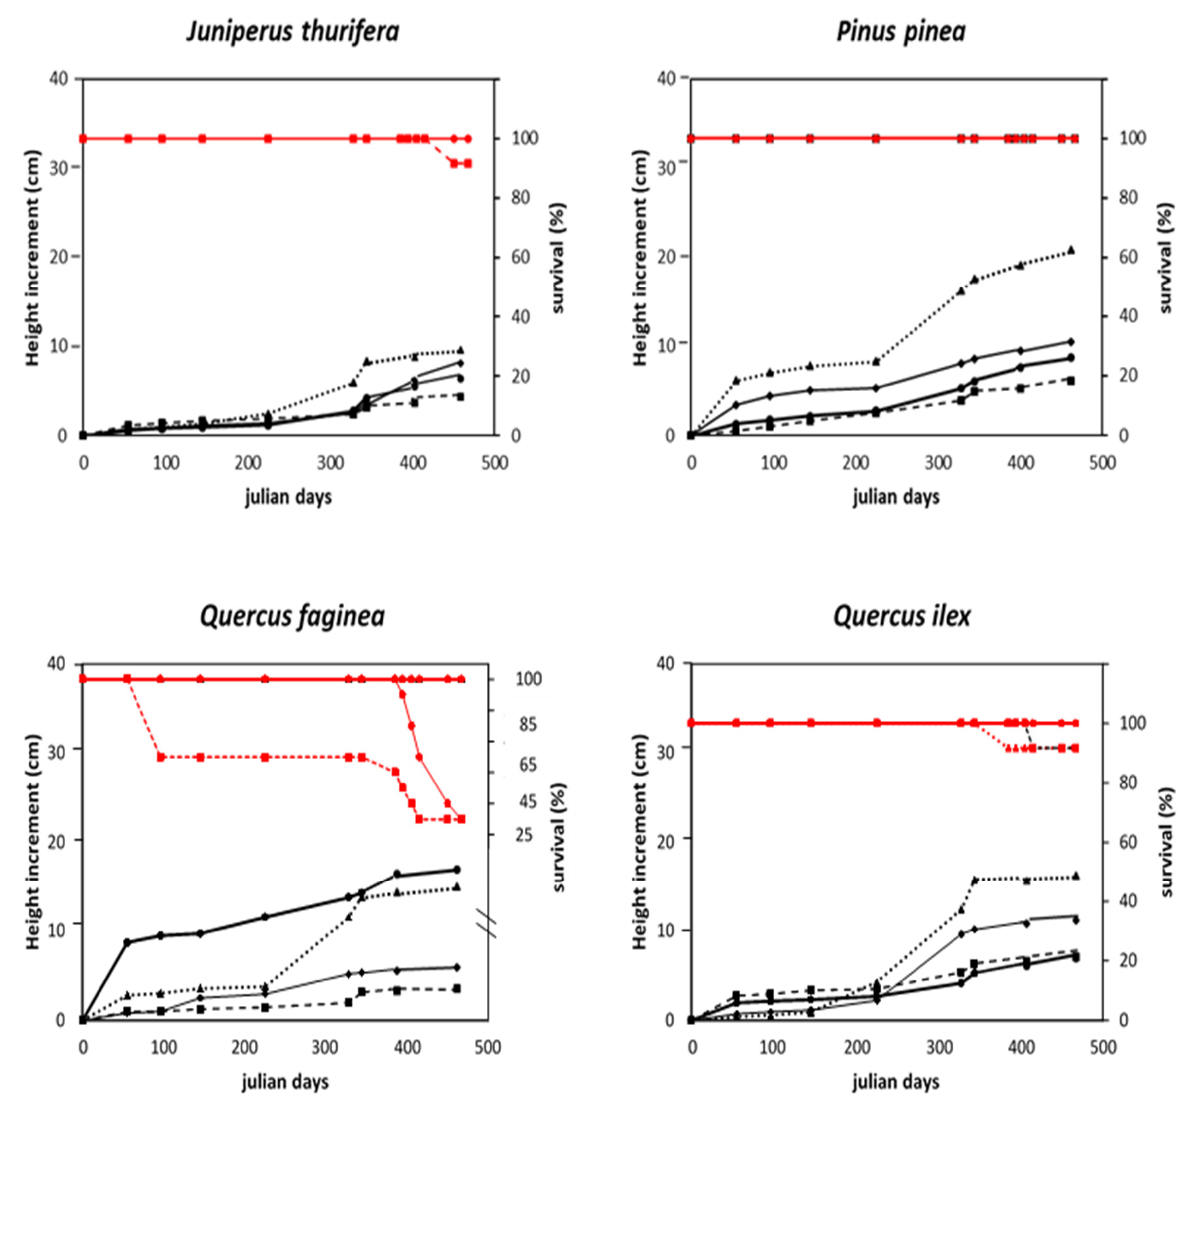
Figure 3. Height increment (cm) (in black) and survival (%) (in red) during the experimental period for each treatment combination in the four studied species.